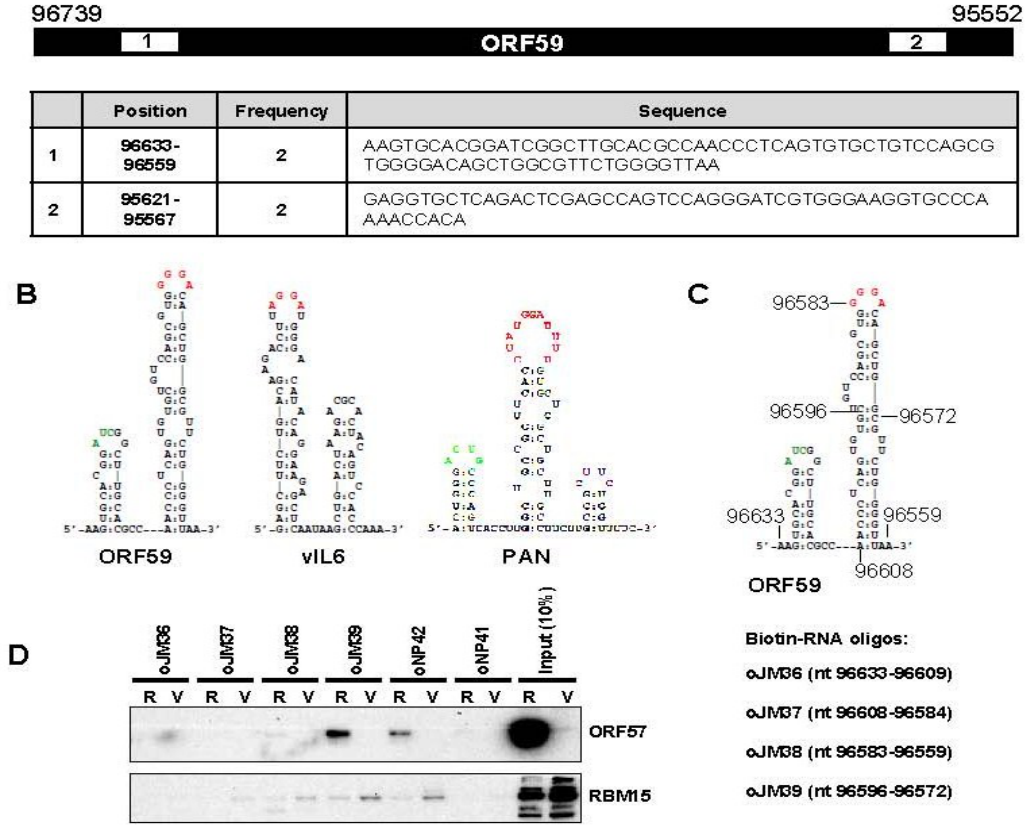
Figure 2. A MRE in the 5’ ORF59 interacts with ORF57 and RBM15. ( A ) Two ORF59 regions (numbered white boxes) identified in ORF57 CLIP assay [18]. Below is the table showing their positions, cloning frequency and nucleotide sequence. ( B ) Secondary structures of the identified RNA sequences in ORF59, vIL6 and PAN RNA by anti-ORF57 CLIP. The nucleotide sequences in the stem-loop in red color are the interacting site for ORF57 and its associated cellular proteins. ( C ) The ORF59 5’ MRE structure with the nt positions of biotinylated RNA oligomers used in RNA pull-down assays. ( D ) KSHV ORF57 and cellular RBM15 preferentially bind to a stem-loop structure of the MRE. Cell lysates prepared from TREx BCBL1-RTA (R) or -vector (V) cells induced with Dox for 24 h were used for the RNA pulldown assays with an indicated RNA oligomer. The RNA oligo oNP42 derived from vIL6 RNA was used as a positive control and oNP41 oligo as negative control [18]. ORF57 or RBM15 associated with RNA oligos in the pulldowns was immunoblotted using an anti-ORF57 or anti-RBM15 antibody. The cell lysate (10%) prior to the pulldown served as an input control in Western